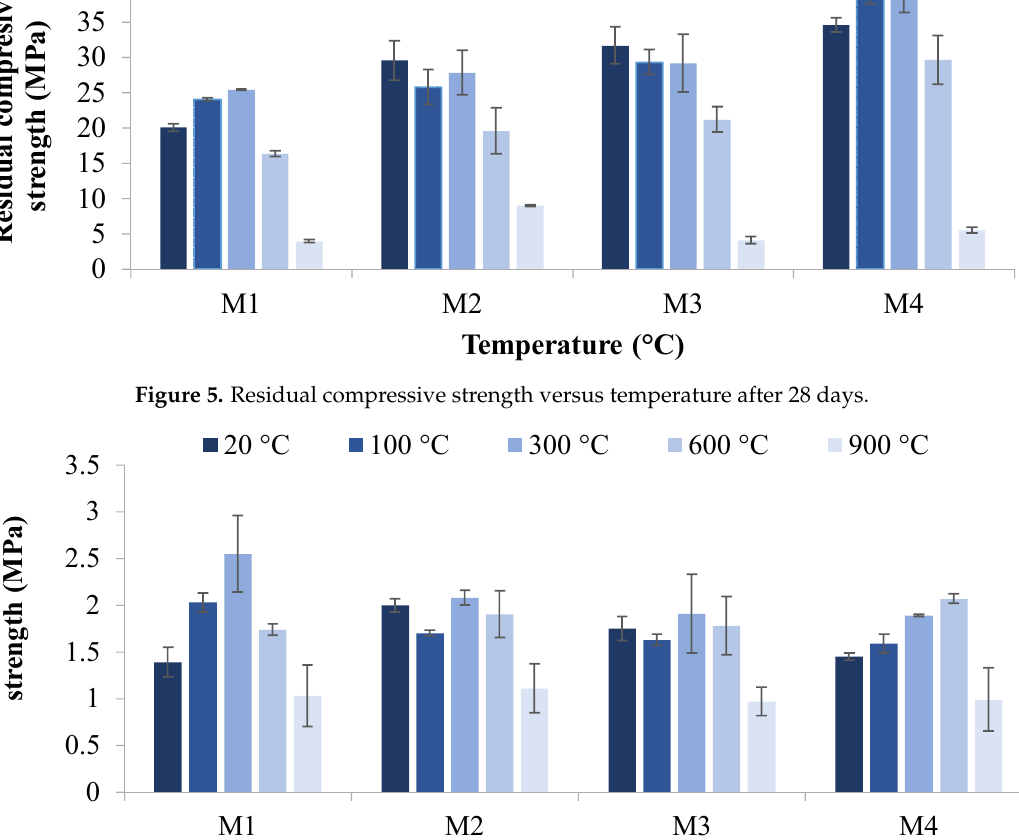
Figure 6. Residual tensile strength versus temperature after seven days.